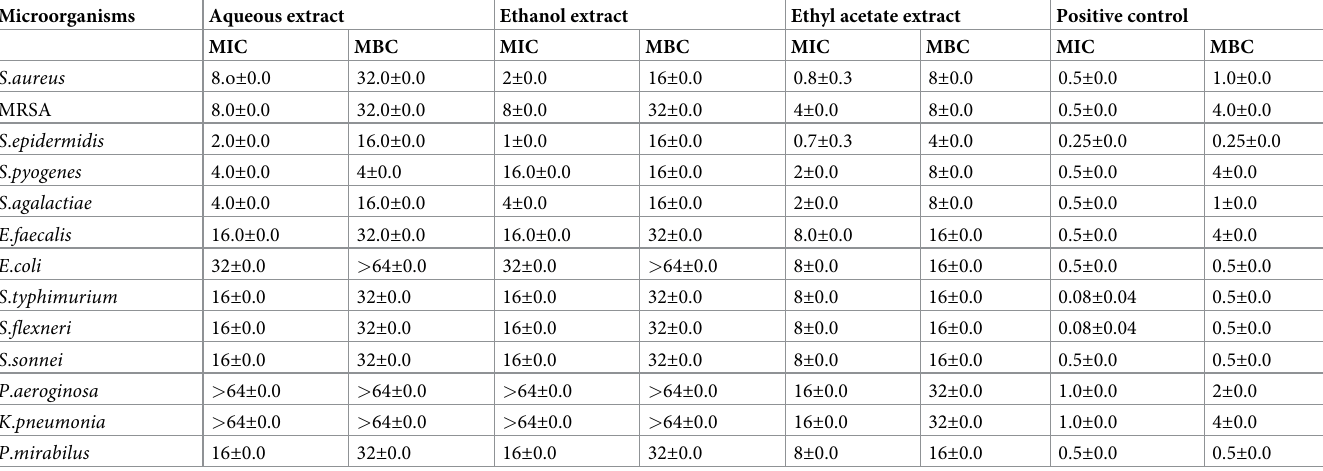
Table 3. MIC and MBC values of the tested microorganisms.